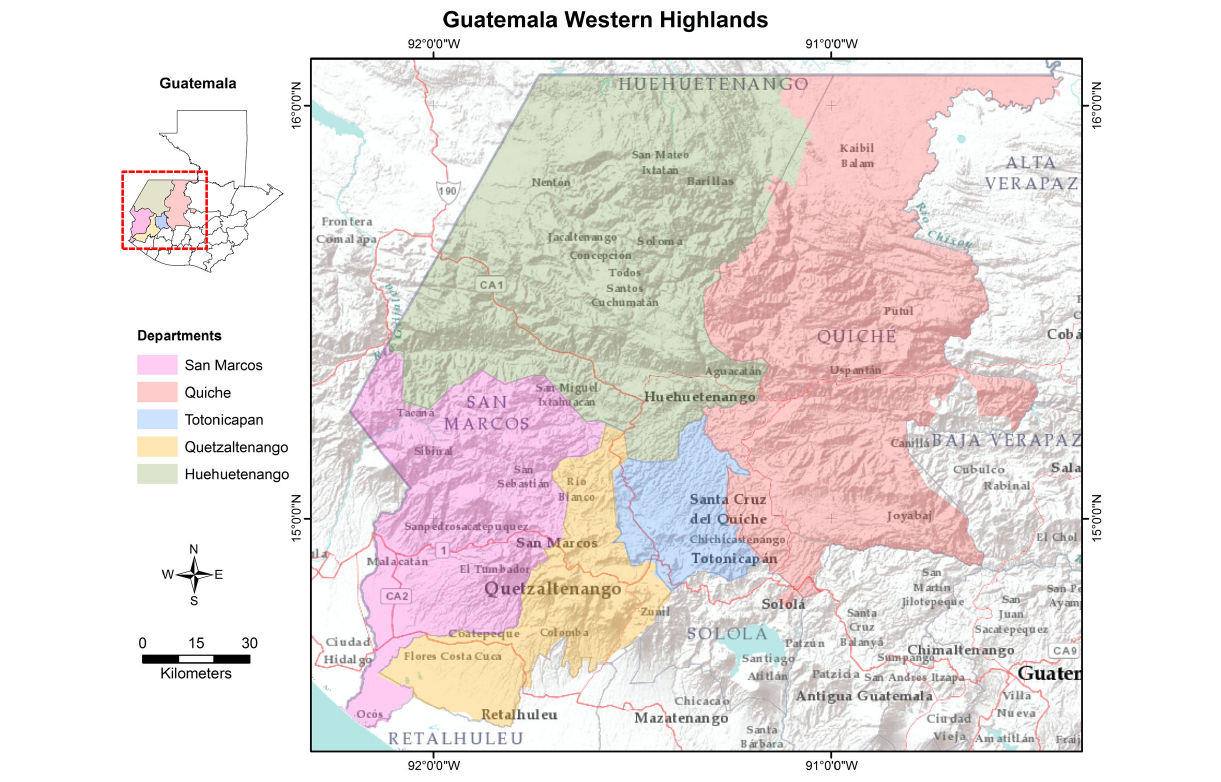
Fig. 2 . Western Highlands, Guatemala. Cartography: Santiago López-Ridaura and Luis